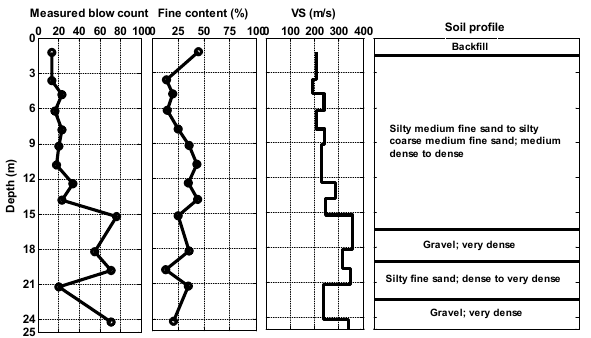
Figure 8: Profile of soil according to the depth (Nantou site).